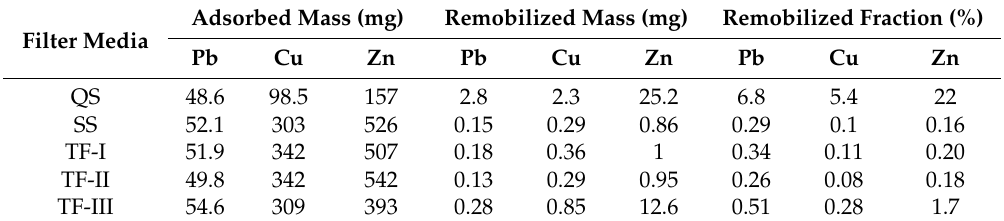
Table 4. Heavy metals adsorption and their remobilization/desorption using 42 L solution of 5 g/L